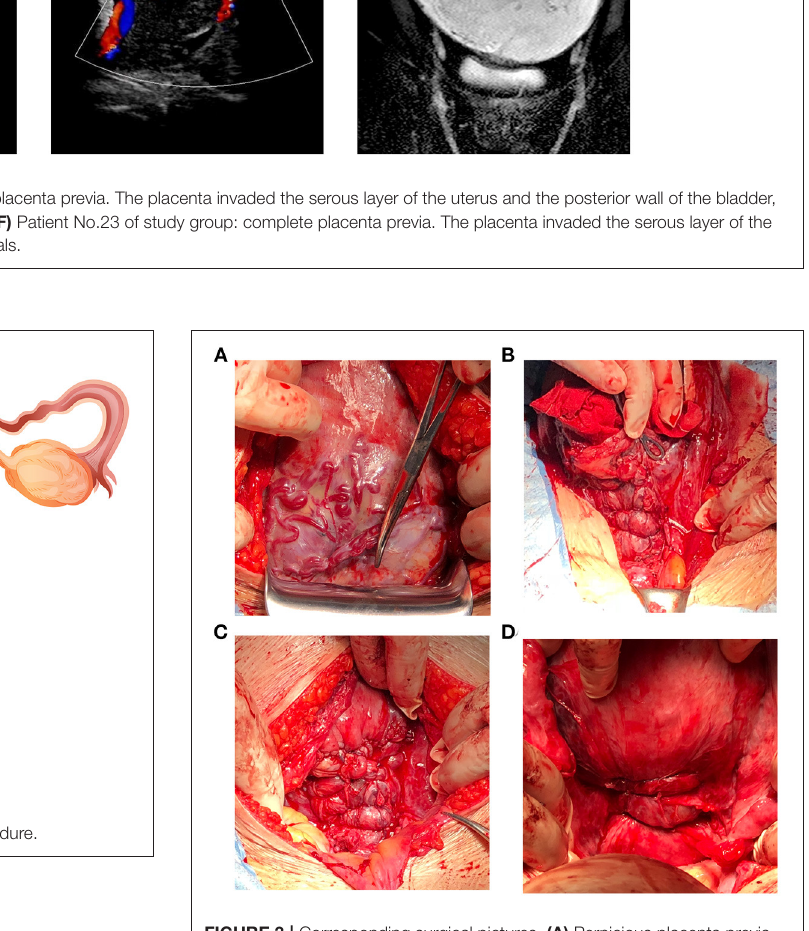
FIGURE 3 | Corresponding surgical pictures. (A) Pernicious placenta previa complicated with placenta increta. (B,C) The anterior wall of uterus after parallel loop binding compression suture was performed, and adequate hemostasis effect was achieved. (D) The posterior wall of uterus after parallel loop binding compression suture was